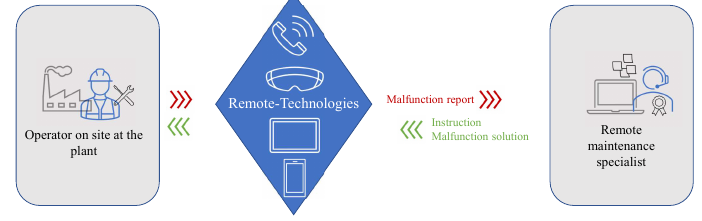
Figure 1. Remote